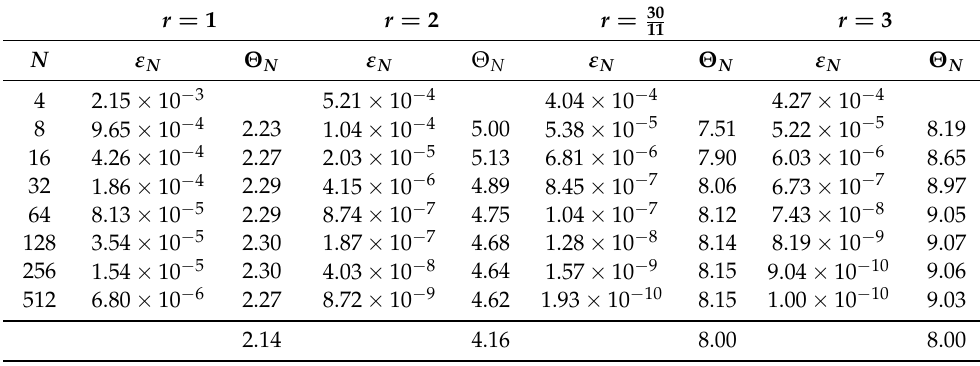
Table 4. Numerical results for problem (71) and (72) with m = 2.